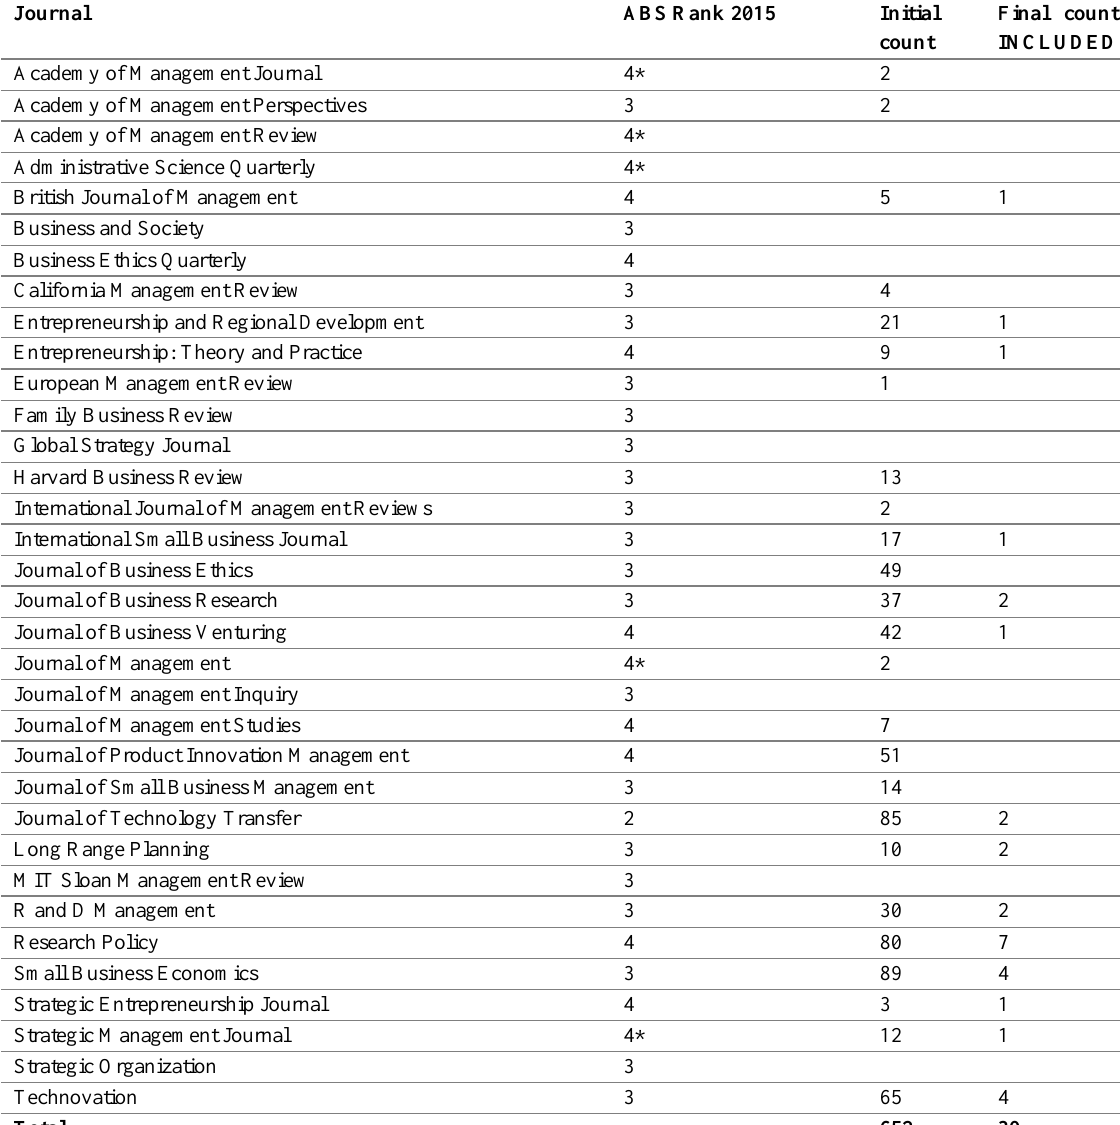
Table 2: List of